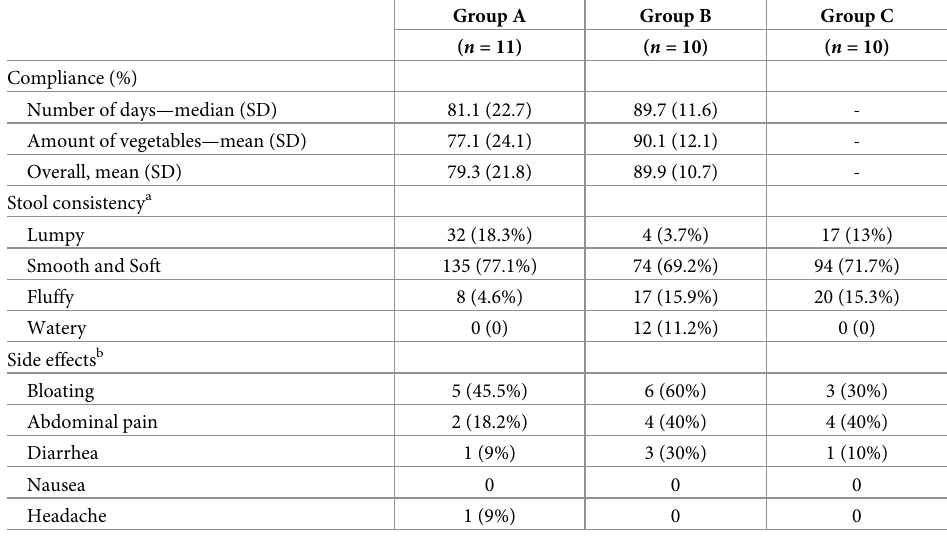
a Expressed as total number of days (%).